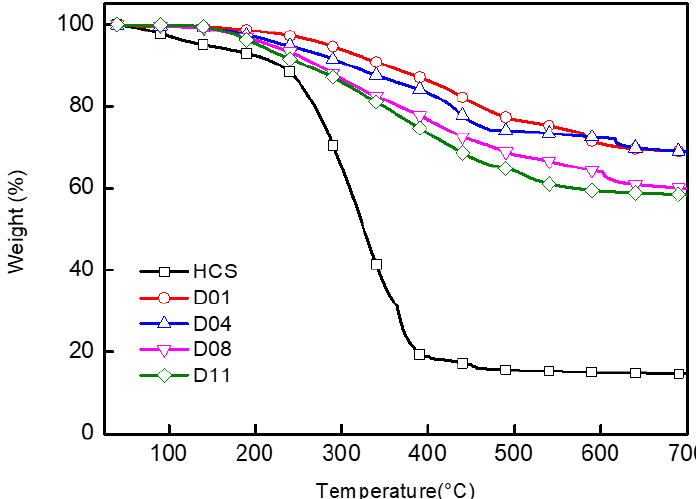
Figure 3. TGA of HCS ( T 5% = 141.5 °C, T 10% = 229.3 °C, R w = 14.63%), D01 ( T 5% = 284.7 °C, T 10% = 351.8 °C, R w = 68.94%), D04 ( T 5% = 235.2 °C, T 10% = 309.5 °C, R w = 69.0%), D08 ( T 5% = 217.5 °C, T 10% = 272.8 °C, R w = 59.96%), D11 ( T 5% = 203.7 °C, T 10% = 259.0 °C, R w = 58.45%).